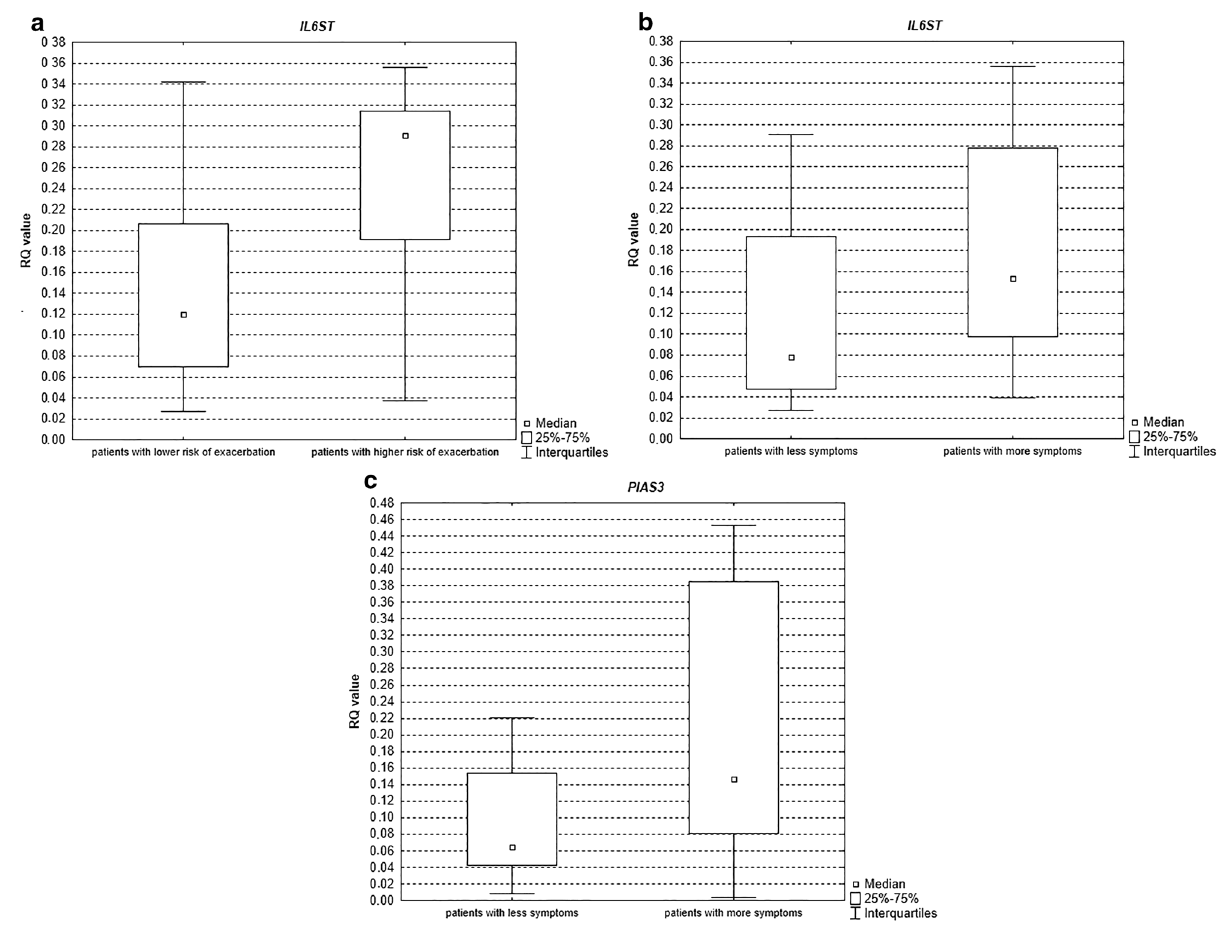
Figure 2. Box-and-whisker plots representing the expression value (median RQ value) of the studied genes in induced sputum: ( a ) IL6ST ( p = 0.01) ( b ) IL6ST ( p = 0.04) ( c ) PIAS3 ( p = 0.04).